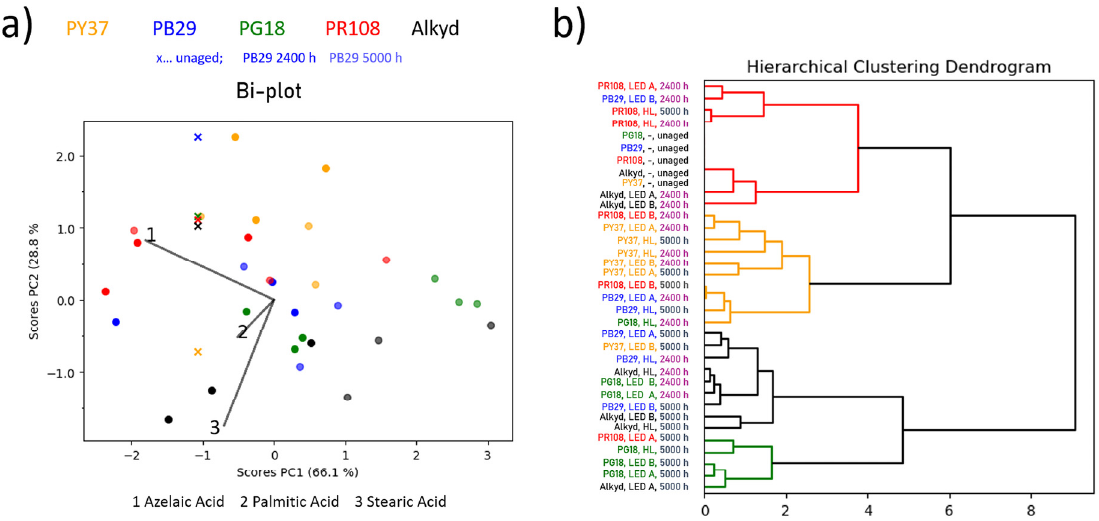
Figure 3. ( a ) Bi-plot (scores and loadings plot of PC1 vs. PC2) for alkyd-based mock-ups. The colour of the scores corresponds to the pigment type (e.g., blue-coloured score = blue pigment; the binder without pigment is depicted in black) and its transparency to the ageing time when exposed to various illuminants (higher transparency indicated longer exposure times; unaged sample is indicated by a cross). ( b ) Dendrogram of the HCA of the PC1 and PC2 scores with the sample names highlighted according to the pigment type or ageing time, respectively.